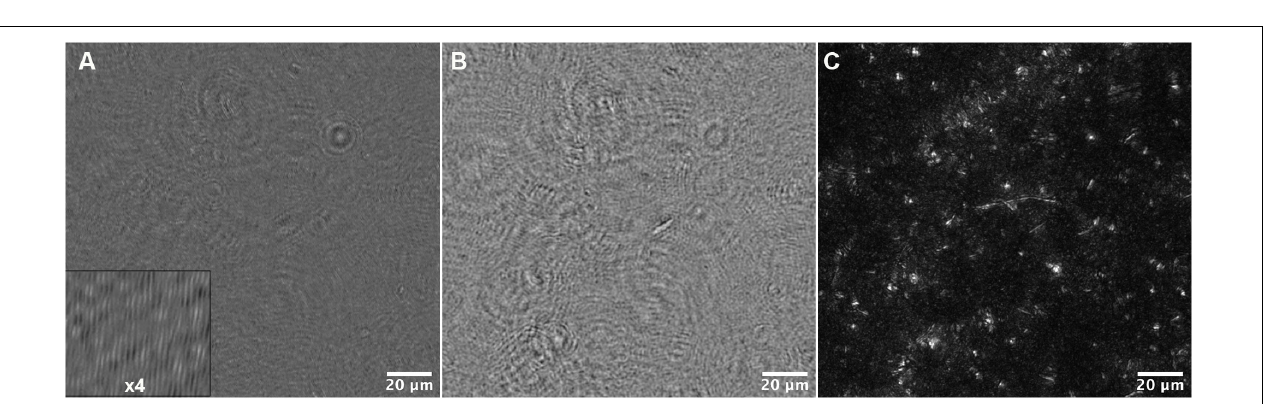
FIGURE 4 | Cell sizes and diffusion coefficients with temperature. (A) Cell area as estimated by microscopy, shown as mean ± standard deviation. The differences in the means from one temperature to the next was not significant. (B) Measured diffusion coefficients at 3 temperatures (black dots), with measured standard deviations, compared with predicted values according to Eq. (1) for particle radii of 2.0, 2.5, and 3.0 µ m.